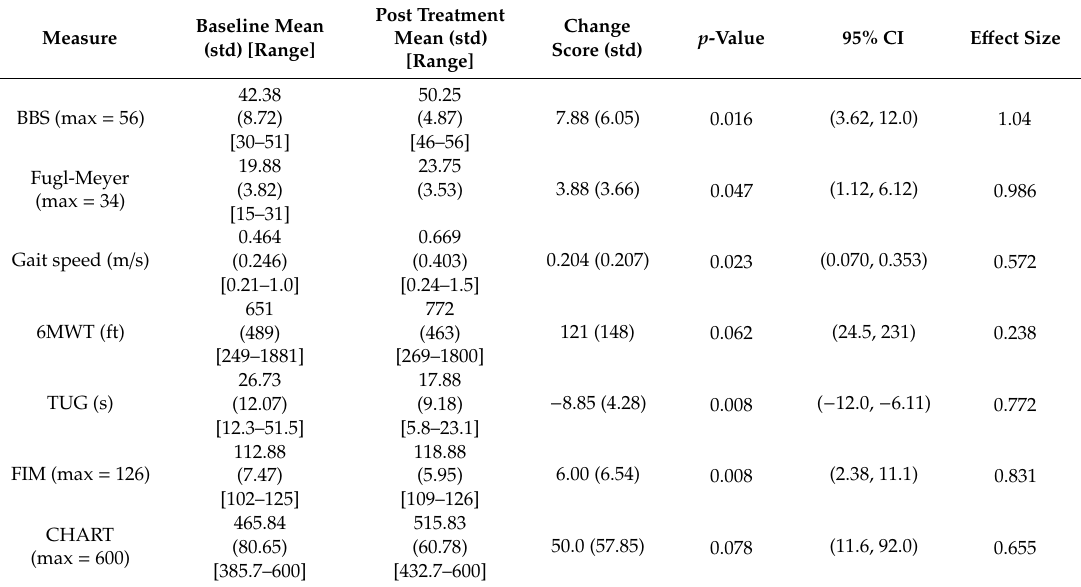
Table 2. Statistically Significant Improvement in Balance (BBS), Joint Movement Coordination